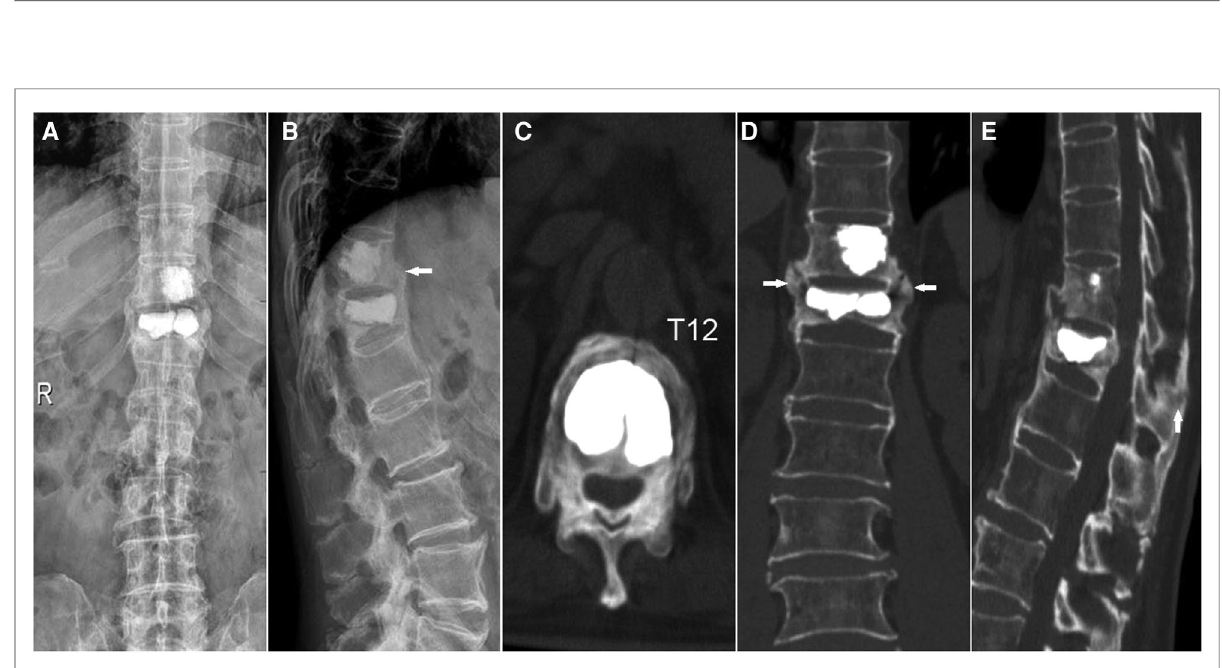
cord is oppressed by fractural vertebral fragments, open internal fi xation with decompression is suggested as the prime